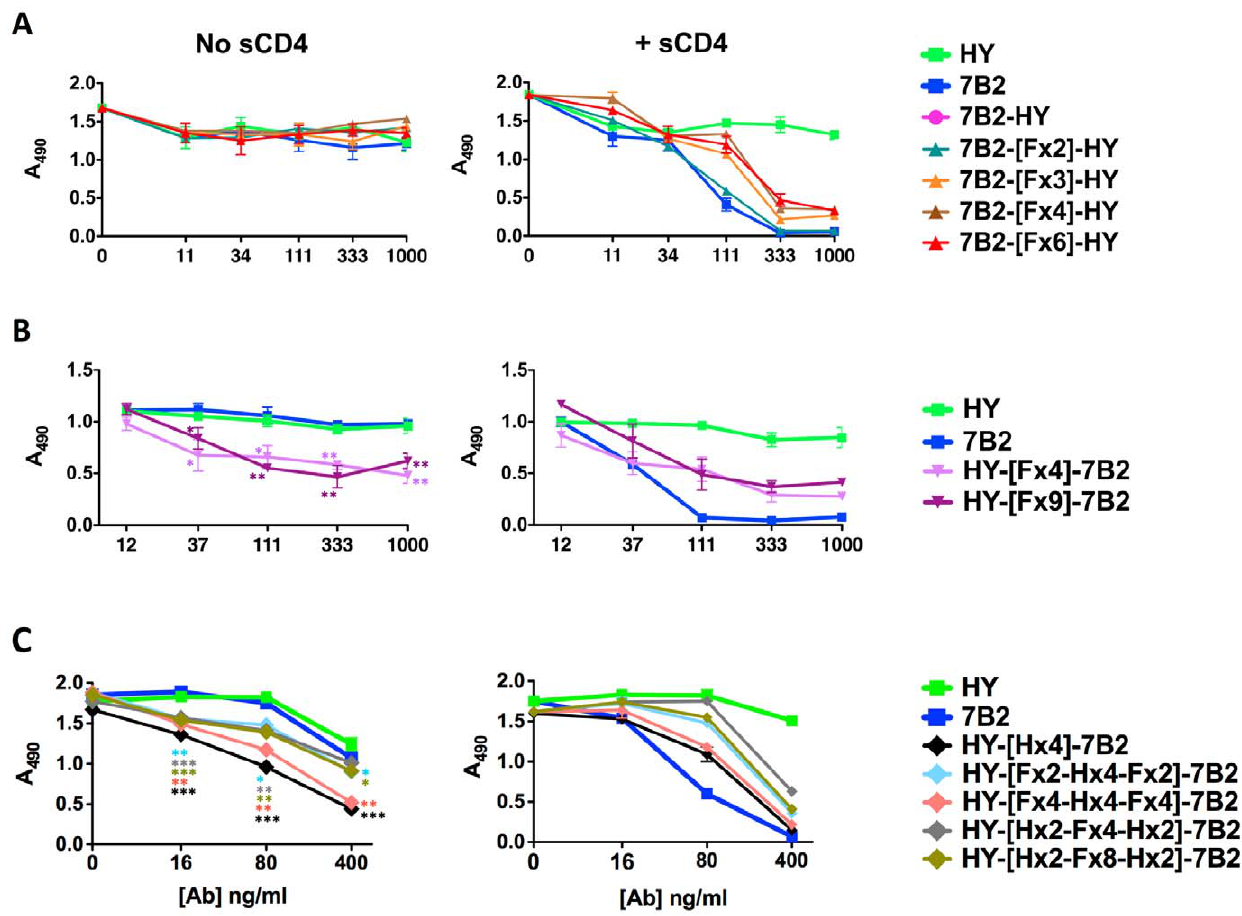
Figure 6. Delivery of a cytotoxic immunoconjugate by DVD-Igs. The ability of DVD-Igs to target and kill infected cells was examined using an indirect immunoconjugate (IC) killing assay. H9/NL4-3 cells were incubated for 1 hr with Abs in the presence (R) or absence (L) of sCD4 (300 ng/ml), followed by addition of 500 ng/ml ricin A chain-conjugated anti-IgG secondary Ab. After 3 days, cell viability was measured at 490 nm after adding MTS/PMS. Data are plotted as absorbance versus Ab concentration. A. DVD-Igs with 7B2 as the outer domain, using flexible linkers. B, DVD-Igs with HY as the external domain and flexible linkers. C. DVD-Igs with HY as external domain and helical linkers. Each DVD-Ig was tested in 2–4 separate experiments, shown here is one representative experiment for each set of DVD-Igs. Statistically significant improvements in DVD-IC activity, when compared to the effective parental Ab 7B2, are indicated by asterisks (*p , .05, **p , .01, ***p , .001, by one-tailed t test).